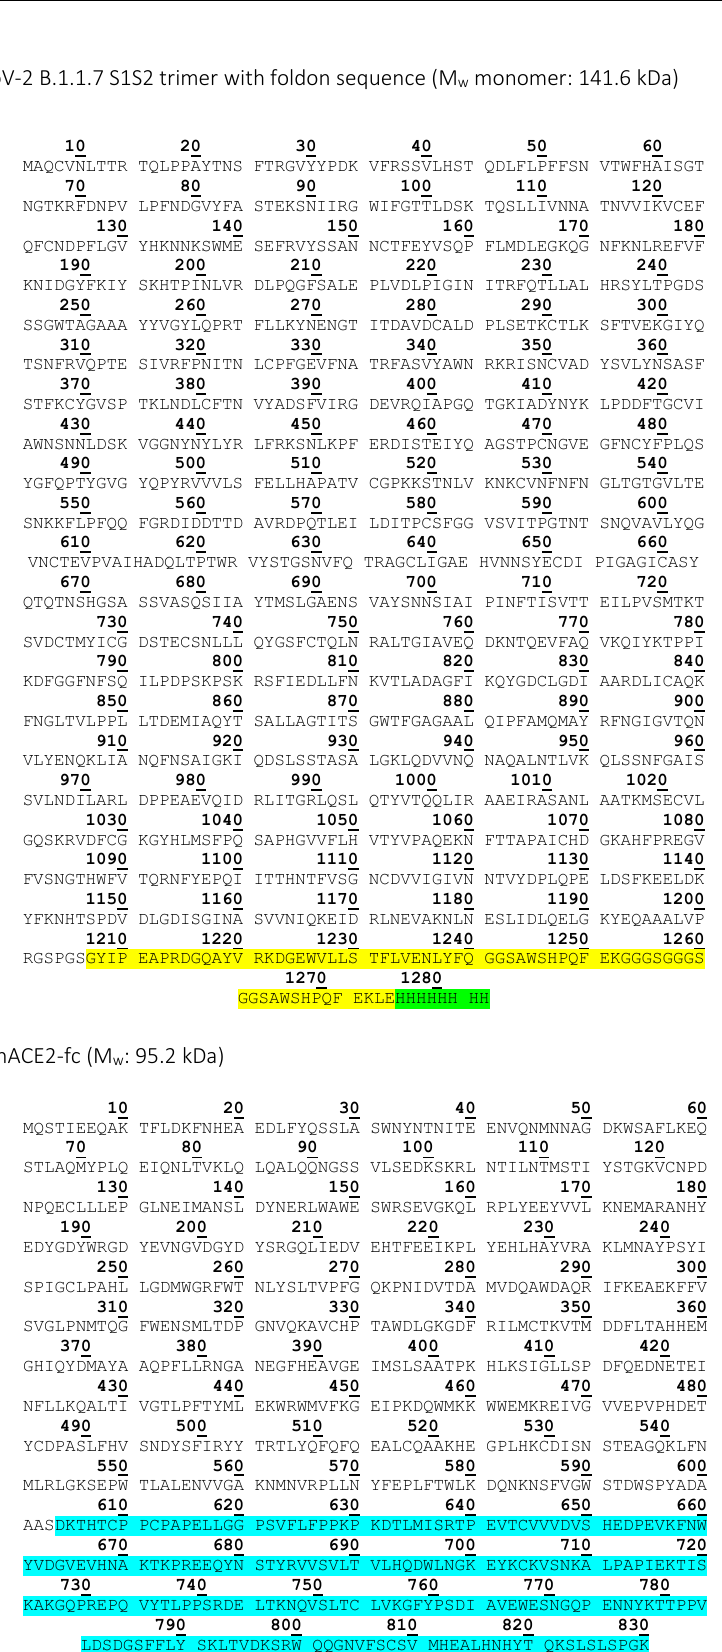
Figure A1. Single letter amino acid sequence of the SARS ‐ CoV spike protein and hACE2 constructs used for SPR experiments. T4 fold ‐ on sequences are marked in yellow, Poly ‐ His sequences are marked in green and fc ‐ tags are marked in turquoise.